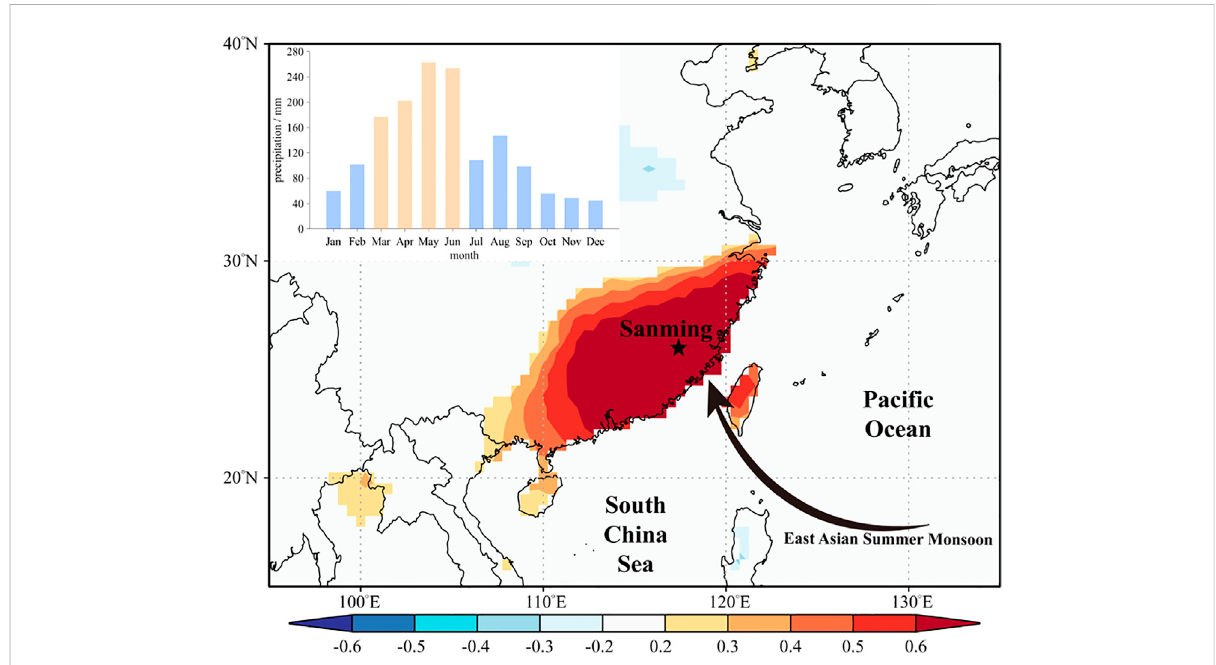
FIGURE 1 StudyareaandsamplingstationsintheSECregion.TheupperleftistheaveragemonthlyprecipitationatYong ’ anstationfrom1951to2012;the black star represents the sampling site in Sanming; background colors represent the whole year spatial correlations between the precipitation in Yong ’ an station and CRU TS4.05 precipitation (from 1951 to 2012, p <